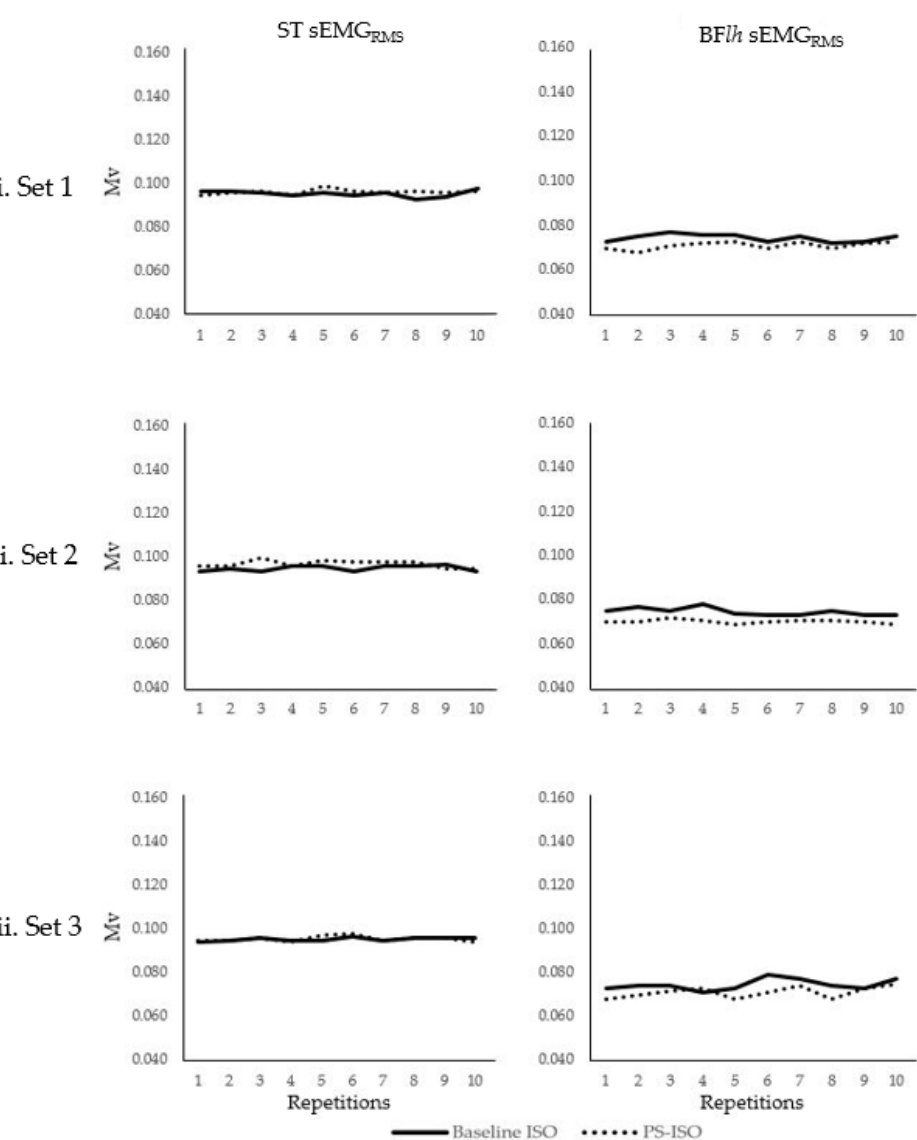
Figure 3. Mean baseline isometric and PS-ISO muscle activation (sEMG RMS ) measured in millivolts (Mv) of semitendinosus (ST) and biceps femoris long-head (BF lh ) muscles during 10 consecutive repetitions during 3 sets ( i. Set 1 , ii Set 2 and iii Set 3 ). No difference in muscle activation was observed between baseline isometric and PS-ISO contractions for all repetitions and sets of semitendinosus ( p = 0.590) and biceps femoris long-head ( p = 0.198). ST sEMG RMS is depicted in the left column and BF lh sEMG RMS is depicted in the right column for Set 1 ( i Set 1 ), Set 2 ( ii. Set 2 ) and Set 3 ( iii. Set 3 ). Repetitions in each set are visualized on the x axis and sEMG RMS on the y axis of each graph.